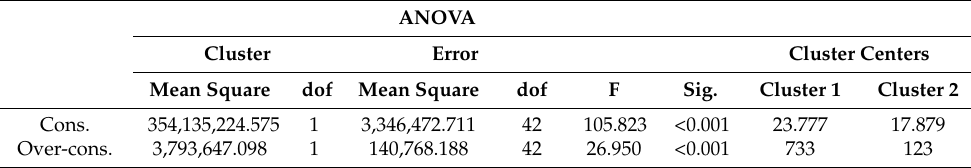
Table 6. ANOVA result of the clustering according to consumption (cons.), over-consumption (over-cons.) variables, and the final cluster